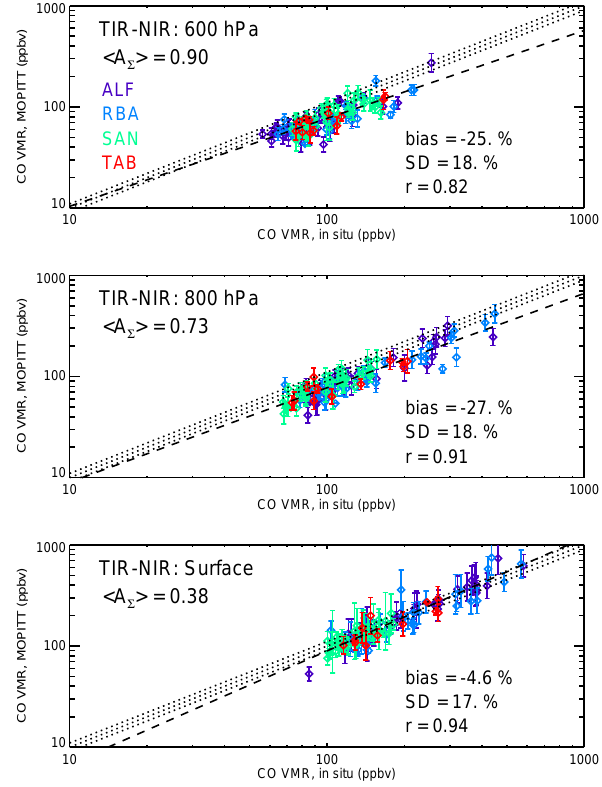
Figure 4. MOPITT Version 6 TIR-only validation results for MO- PITT mid- and lower-tropospheric CO retrievals based on aircraft profiles acquired at four Amazonian sites: Alta Floresta (ALF), Rio Branco (RBA), Tabatinga (TAB), and Santarém SAN). Validation statistics are based on log(VMR), to be consistent with the retrieval state vector. Vertical error bars indicate the variability (standard de- viation) of the MOPITT data used to calculate each of the plot- ted mean values. Each panel shows the least-squares best-fit line (dashed) as well as boundaries around the ideal one-to-one line cor- responding to ± 10% errors (indicated by the dotted lines). Sum- mary statistics (bias, standard deviation, and correlation coefficient) are listed on each panel in addition to the mean kernel area ( A (cid:54) ); this diagnostic provides a useful index for a priori dependence.